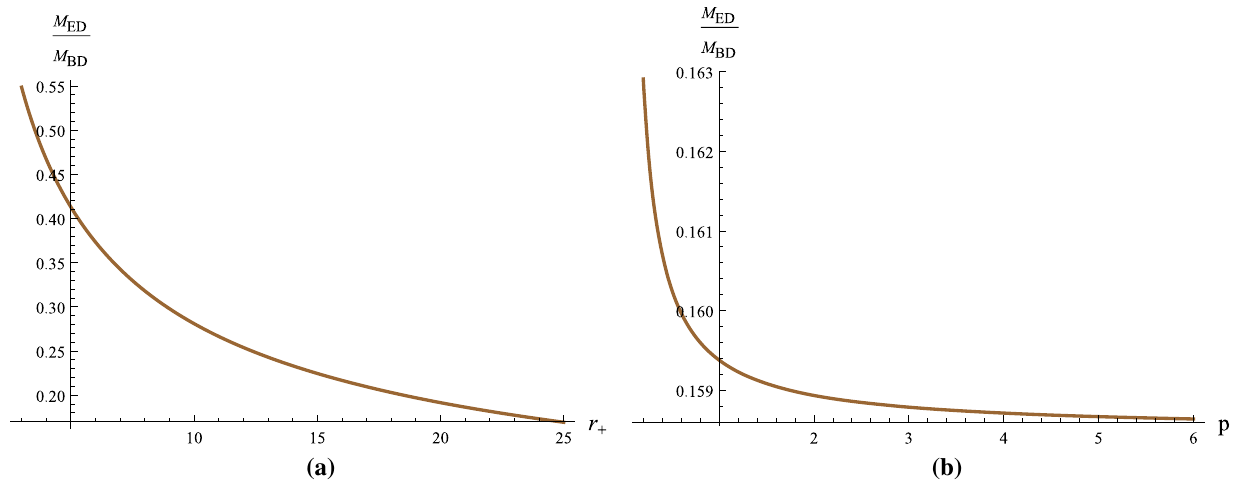
Fig. 12 Plots for the ratio of enthalpy in Einstein theory to enthalpy in BD theory ( M ED / M BD ) a vs. r + at p = 3 ,α = 0 . 4 b vs. p at